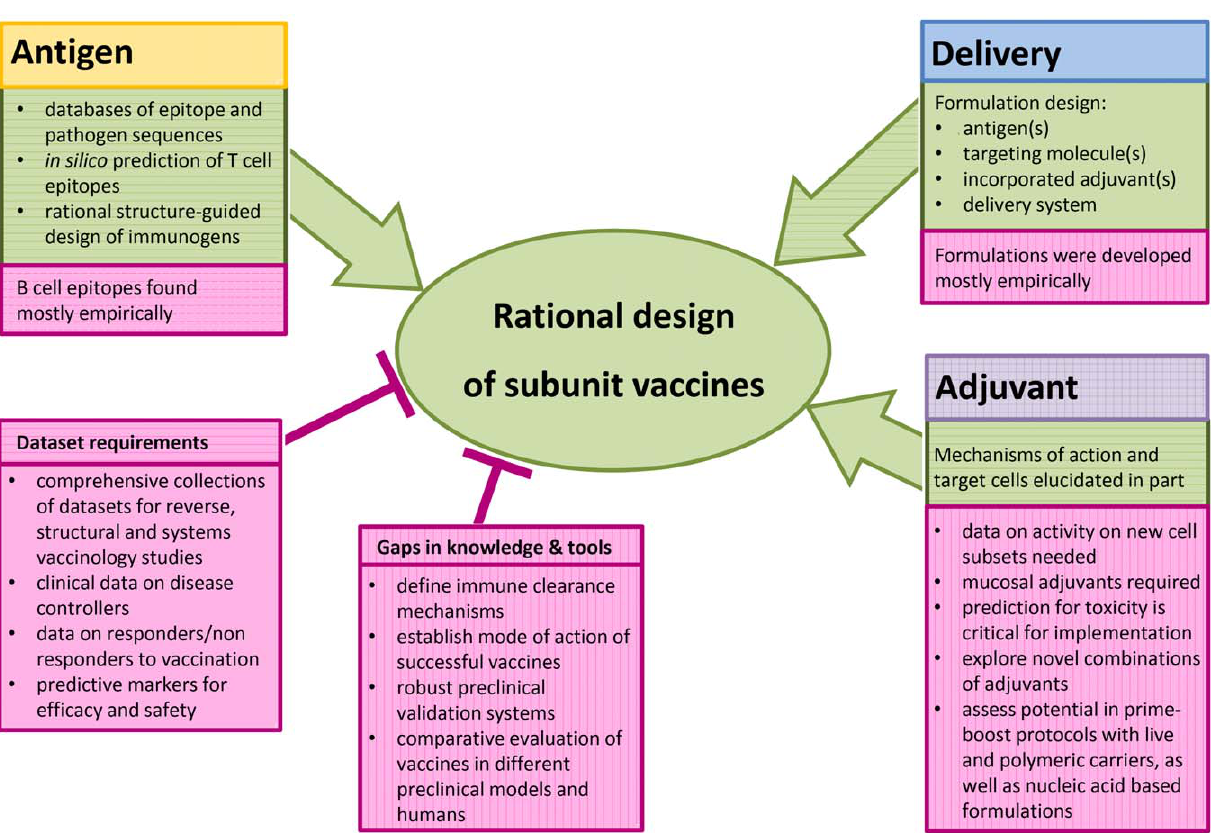
Figure 1. Optimizing the design for more efficient vaccines. Modern vaccinology focuses on the development of subunit vaccines to maximize efficacy and minimize risks in healthy and immune-compromised individuals. Different enabling technologies and knowledge contribute towards the rational design of formulations that would not only exhibit improved performance but also reduce the time and costs associated with preclinical and clinical development. Promising approaches/enabling factors and roadblocks are highlighted in green and pink, respectively.